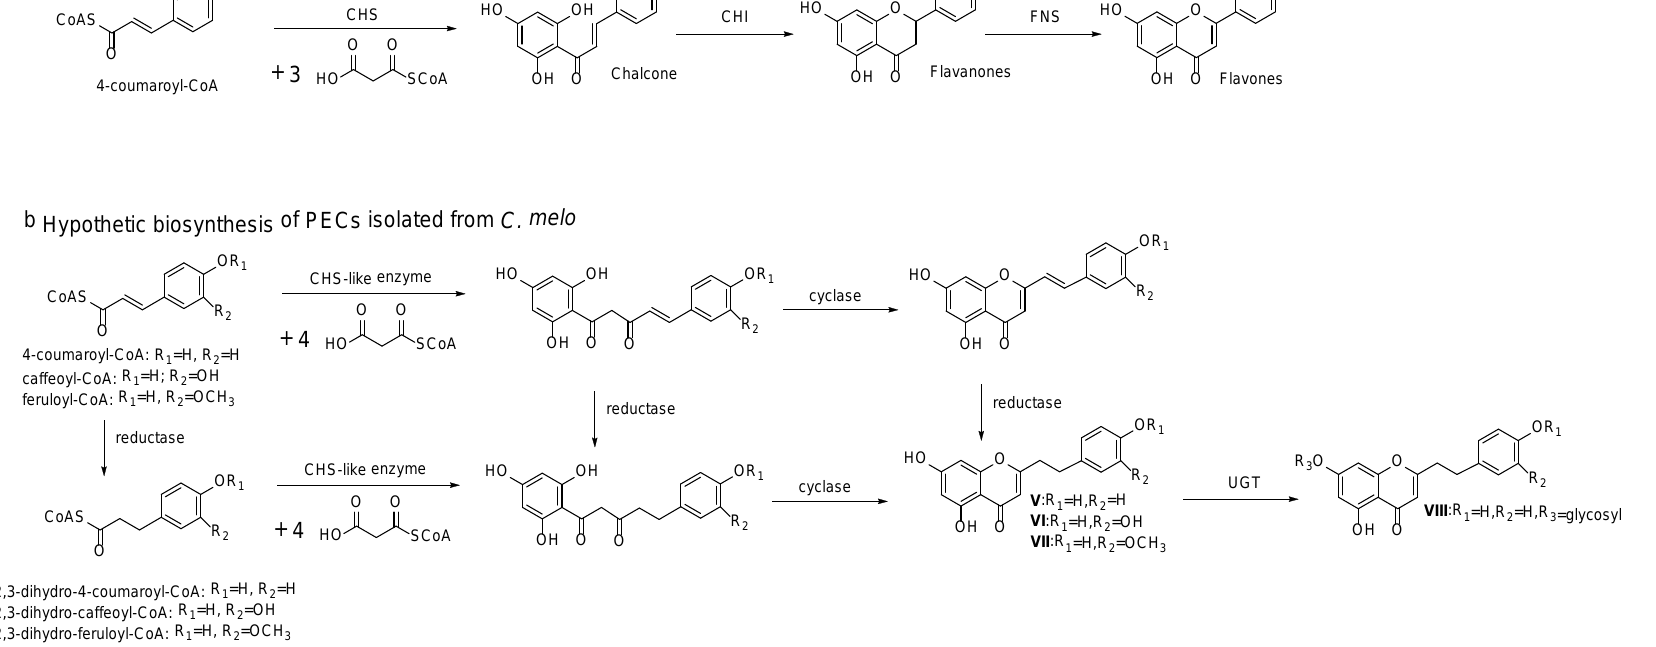
V :R 1 =H,R 2 =H VI :R 1 =H,R 2 =OH VII :R 1 =H,R 2 =OCH 3